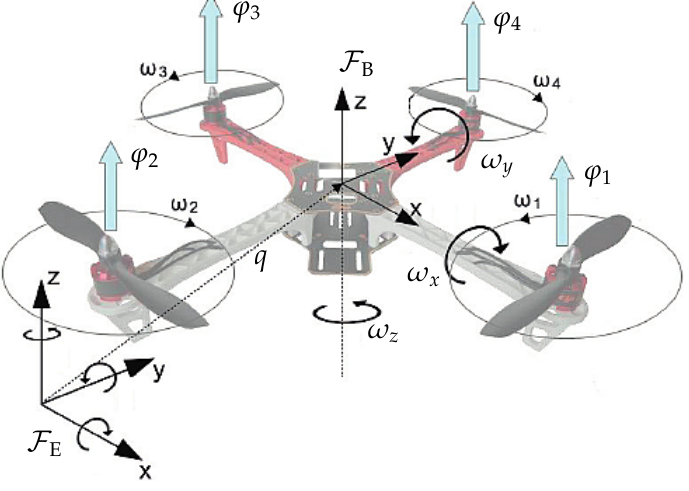
Figure 3. Quadcopter reference